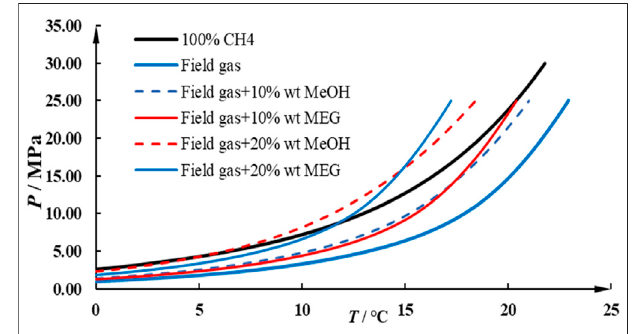
FIGURE11| Diagramof fl owrateandthrottlingholesspeedthroughthe throttling valve in different opening degrees.